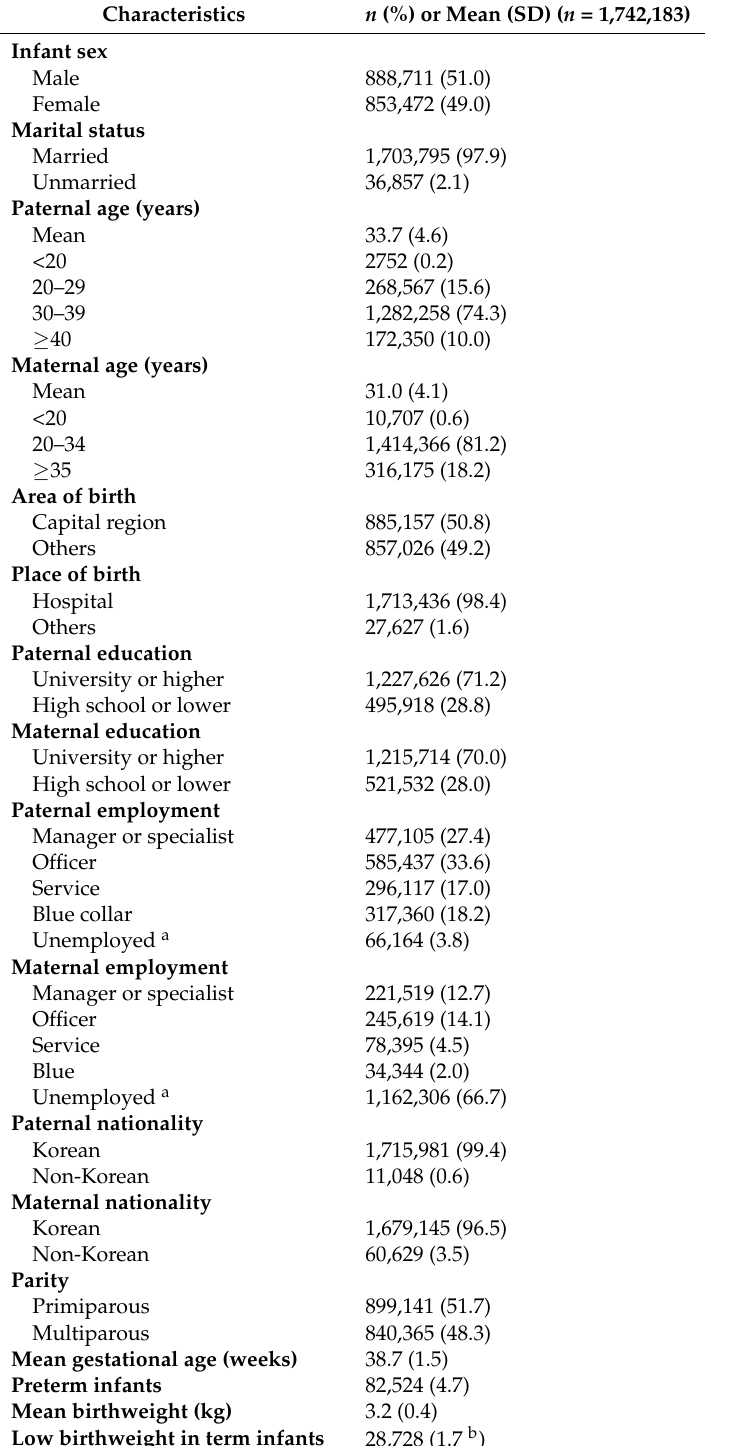
Table 1. Background characteristics of births between 2010 and 2013 in